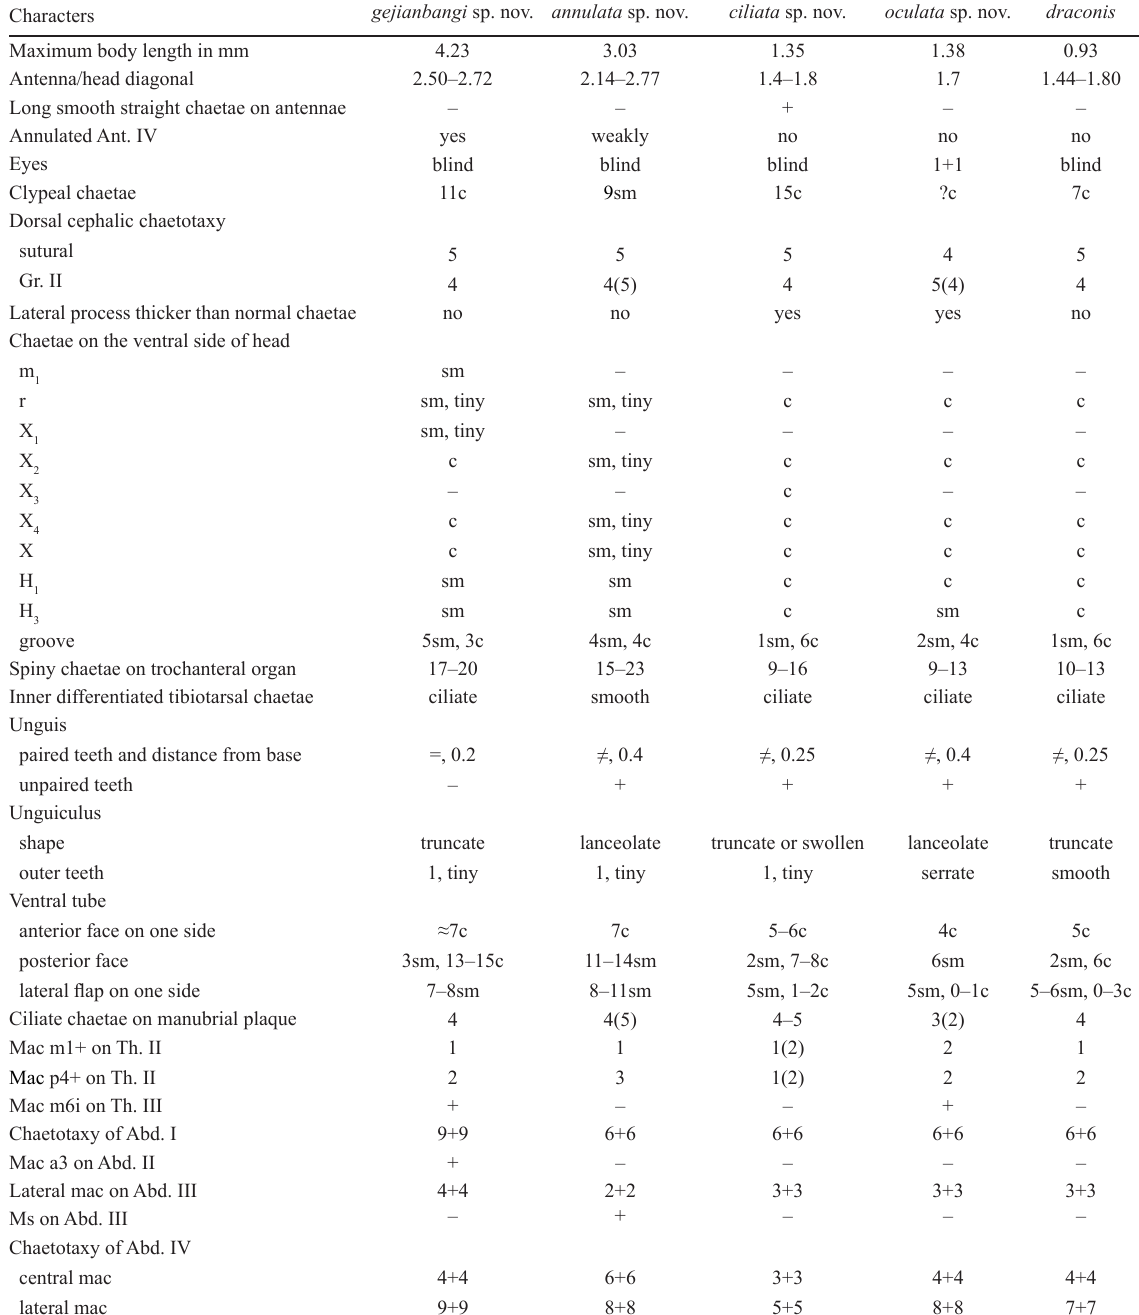
Table 1. Comparison of the five cave Coecobrya species from China (+: present; ‒: absent; sm: smooth; c: ciliate; =: equal; ≠: unequal; ≈